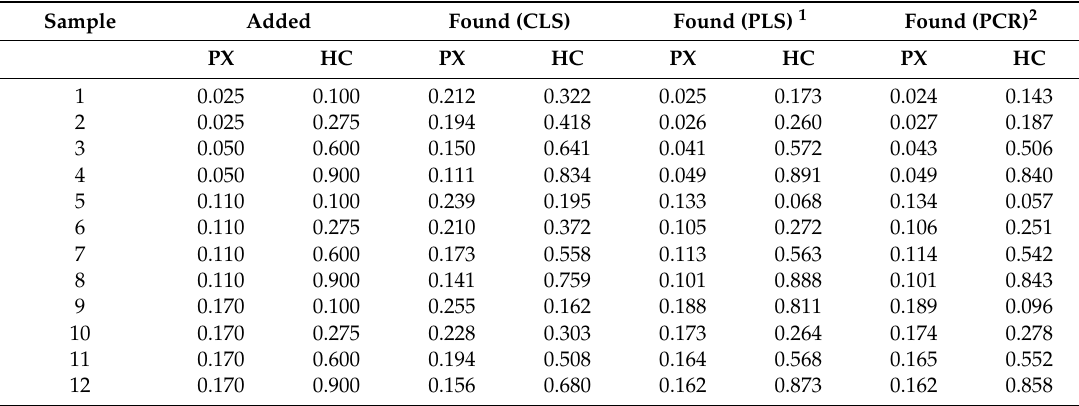
Table 2. Prediction results for pyridoxine(PX) and hydrochlorothiazide(HC) validation samples by di ff erent chemometrics methods ( µ g /